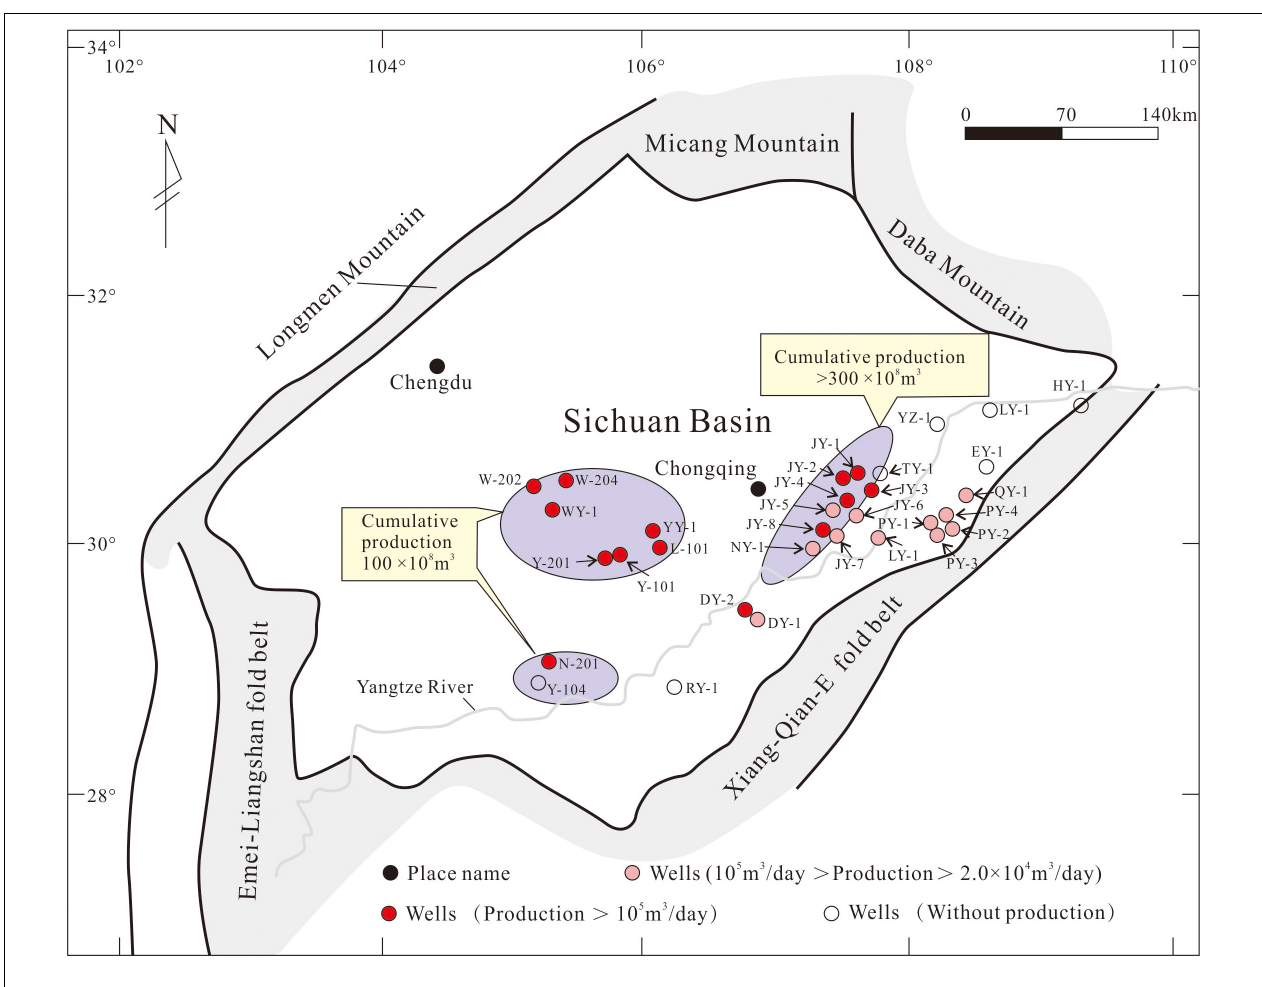
FIGURE 11 | Production map of shale gas wells in the Sichuan